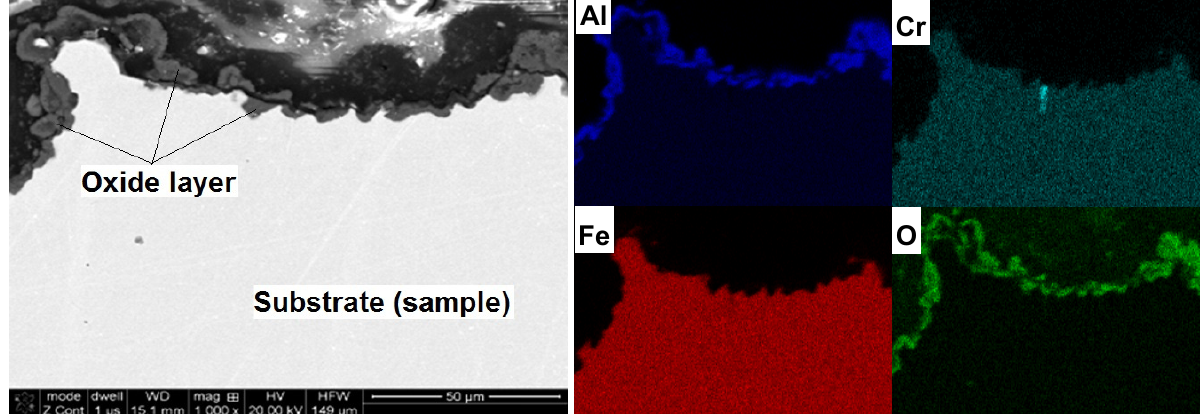
Figure 9. Microstructure (SEM-BSE) and distribution of elements (EDS) cross-section of the A-sample after oxidation at 1200 °C/50 h and mappings of Al, Cr, Fe and